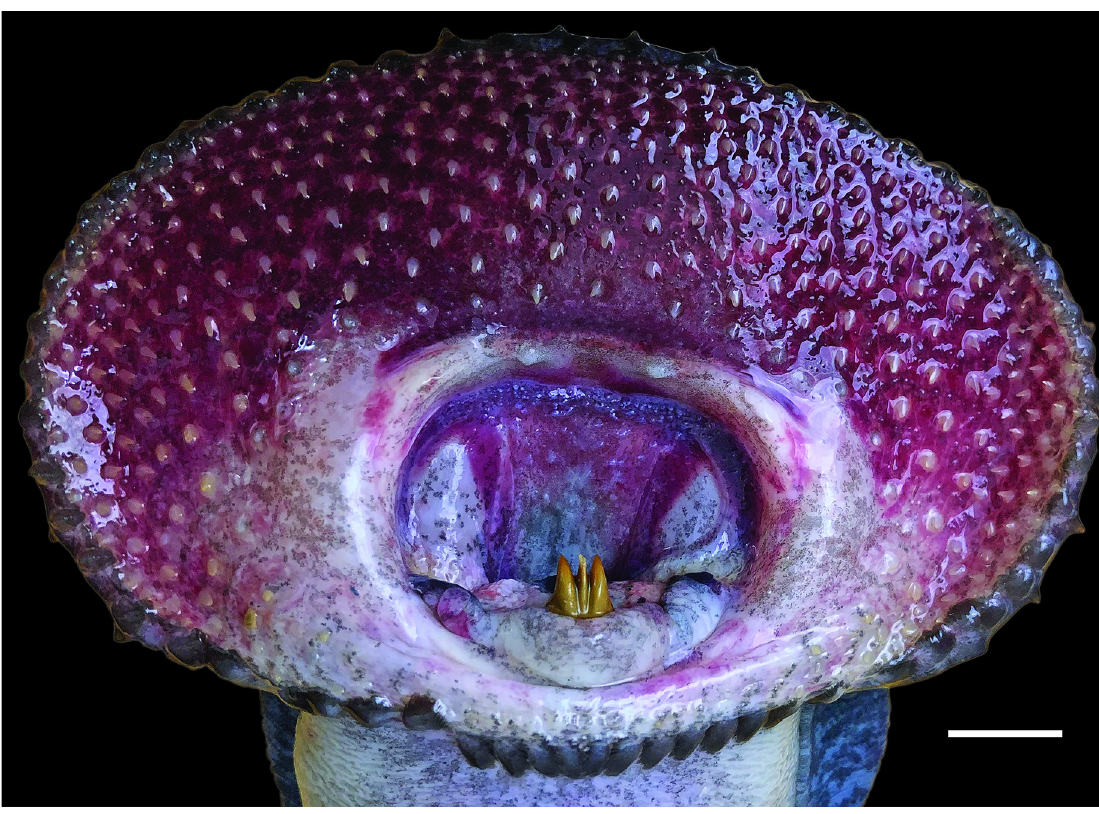
Fig 7. Dentition of a mature male G . macrostoma . Scale bar = 1 cm. The transverse lingual lamina is tricuspid showing two lateral and one central tooth.